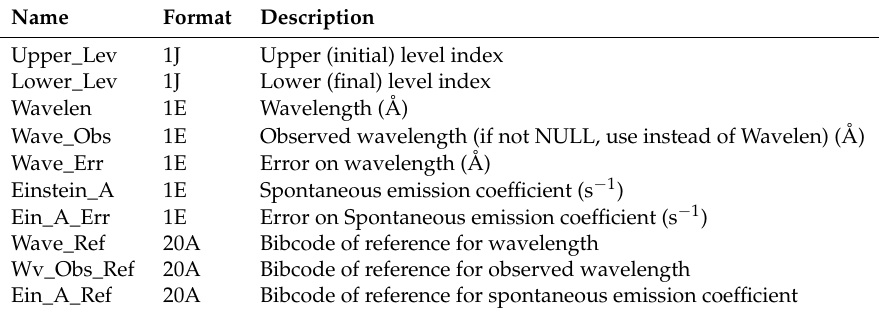
Table A3. APED LA (Wavelength and A-value) file definition.